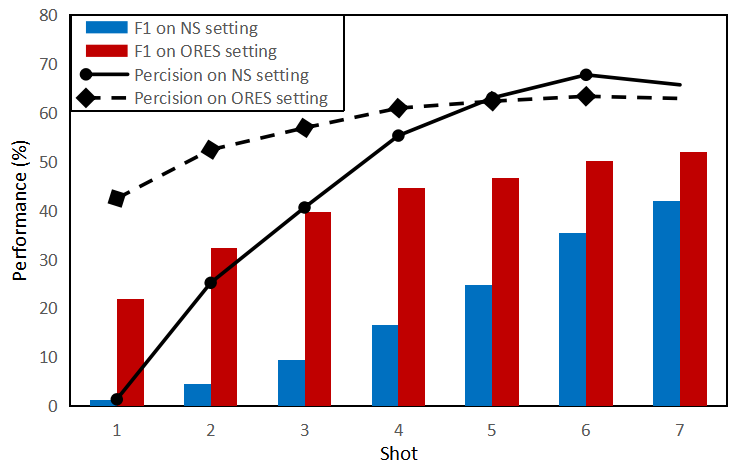
Figure 8. Evaluation results on few-shot of Neural Snowball and Topic Snowball. The horizontal axis are numbers of seed sentences, one relation type.